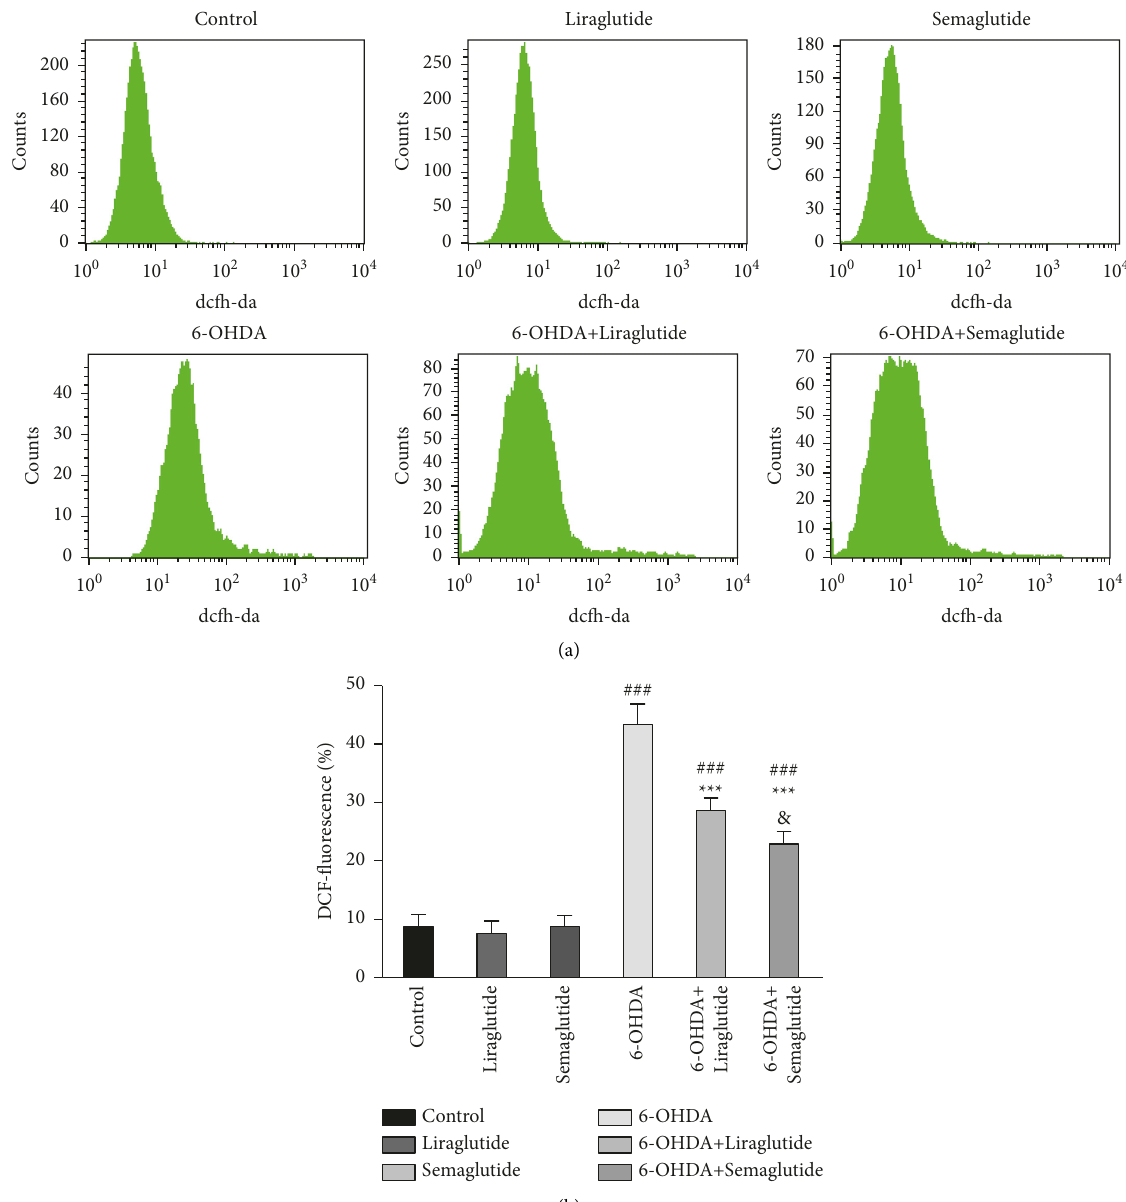
Figure 3: Changes in ROS production in SH-SY5Y cells. (a) Detection of ROS by flow cytometry. (b) ROS expression was upregulated in the 6-OHDA group (### P 0 . 001 vs. the control group). Semaglutide and liraglutide normalized ROS expression ( group) and semaglutide was significantly more effective ( & P standard deviation ( n < (cid:30)